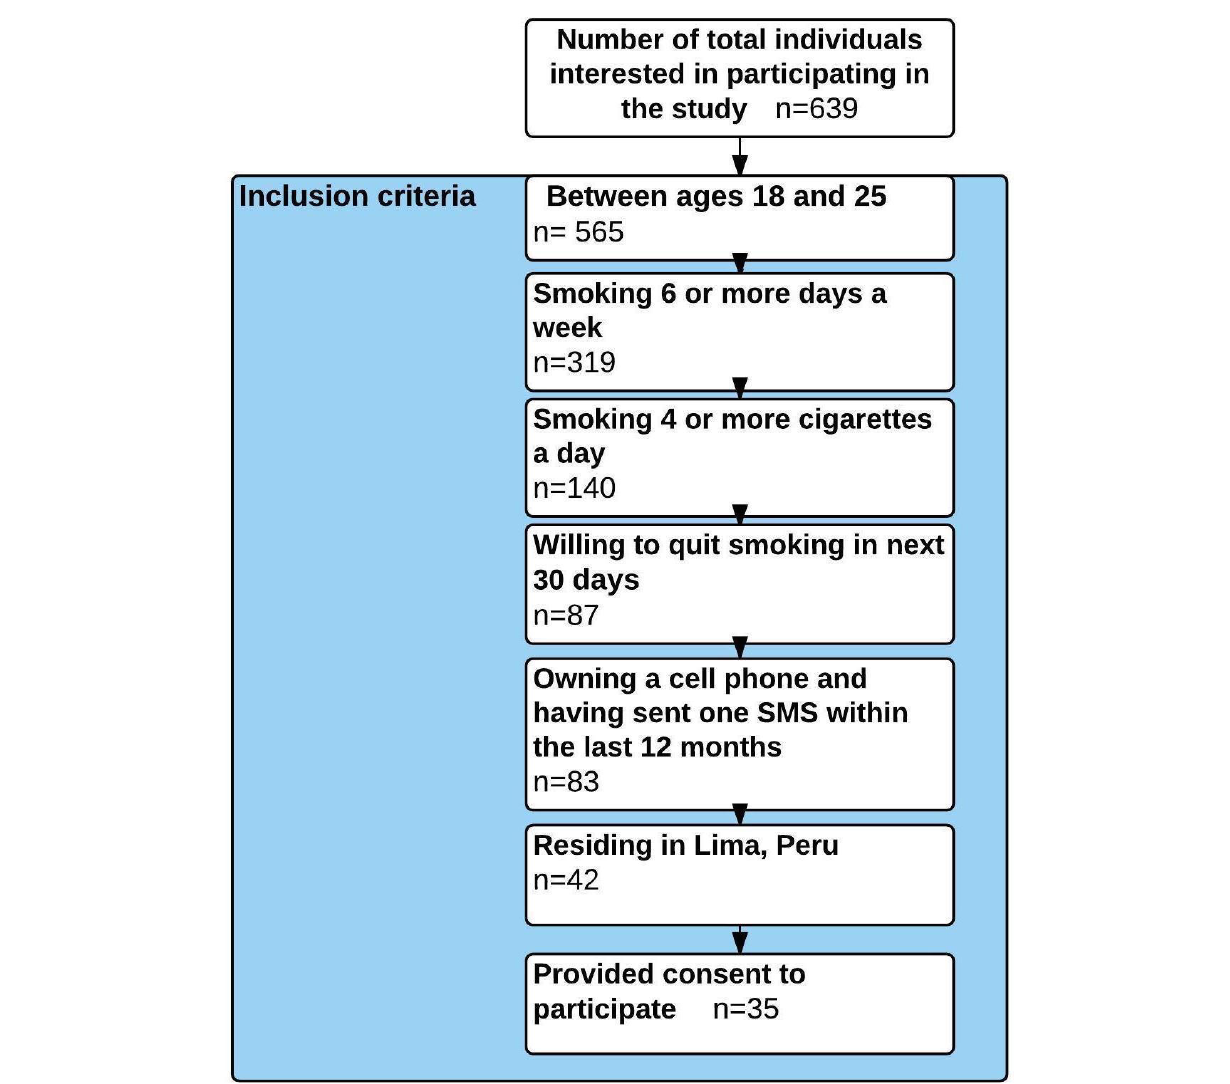
Figure 1. Flowchart of individuals included in the study based on inclusion